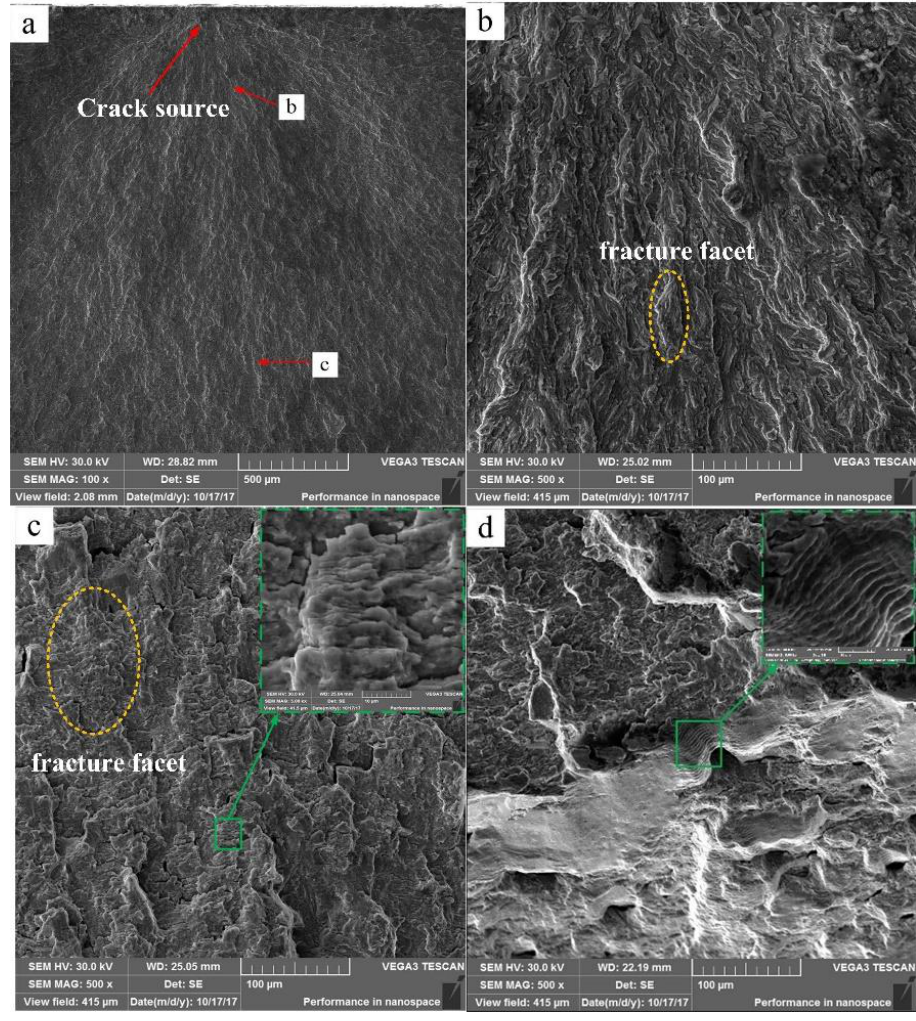
Figure 12. SEM images of the fracture surface of the NP specimen: ( a ) crack source zone ( b , c ) crack propagation zone ( d ) fracture zone.